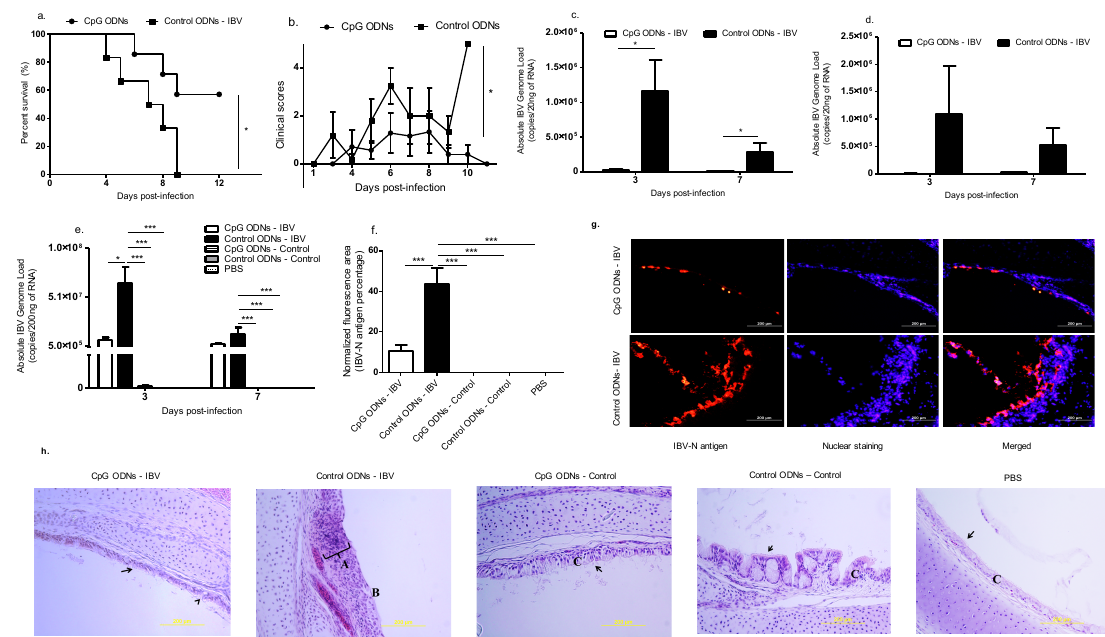
Figure 1. In ovo delivery of cytosine-guanosine (CpG) oligodeoxynucleotides (ODNs) is protective against infectious bronchitis virus (IBV) infection encountered post-hatch. Specific pathogen free (SPF) embryo day (ED) 18 eggs were delivered in ovo with class B CpG ODNs ( n = 7) or control ODNs ( n = 6), and on day 1 post-hatch, the chickens were infected with IBV M41 strain at a dose rate of 2.75 × 10 4 embryo infectious dose (EID 50 ) per bird, and were monitored until 11 days post infection (dpi). ( a ) Survival percentage and ( b ) clinical scores. ( c – h ): SPF ED 18 eggs were delivered in ovo with class B CpG ODNs ( n = 21), control ODNs ( n = 29), and phosphate buffered saline (PBS) ( n = 11). The eggs were incubated until hatching, and on day 1 post-hatch, a subset of in ovo CpG ODN-treated birds was challenged with IBV M41 strain at a dose rate of 2.75 × 10 4 EID 50 per bird ( n = 12), and the rest were kept as in ovo CpG pre-treated uninfected controls ( n = 9). Similarly, a subset of birds in the in ovo control ODN-treated birds was infected with IBV ( n = 18), and the remaining birds were kept as in ovo control ODN-treated uninfected controls ( n = 11). The in ovo PBS treated birds were kept as uninfected controls ( n = 11). A subset of birds from each group was sacrificed at 3 dpi ( n = 5-9 per group), and the remaining birds were sacrificed at 7 dpi ( n = 3–9) in order to obtain lung tissue. ( c ) IBV genome loads in oro-pharyngeal swabs at 3 and 7 dpi, ( d ) IBV genome loads in cloacal swabs at 3 and 7 dpi, and ( e ) IBV genome loads in 3 and 7 dpi lung. ( f – g ) The quantitative data and representative figures from the immunofluorescent assay of the trachea for IBV N antigen is presented. Scale Bar = 200 µ m ( h ) Representative images of histological observations of trachea are given. Control ODNs – IBV: Severe epithelial metaplasia with severe cellular infiltration, germinal center formation is seen (A), superficial epithelial layer has become squamous with complete loss of cilia (B) and mucus glands not detected. CpG ODNs-IBV: pseudostratified simple columnar epithelium and intact ciliated epithelia (arrow) is evident where some have become rounded, and a few mucus secreting glands have been distorted and elongated (arrow head). CpG ODNs-control, Control ODNs-control, and PBS-control: No lesions, normal pseudostratified ciliated columnar epithelium (C) with mucus secreting glands. Log-rank test was used to identify the differences in the survival rate, and the Kruskal–Wallis test followed by the Mann–Whitney U test were used to identify the differences in the clinical scores at selected time points. The student’s t test was performed to identify group differences in the oropharyngeal and cloacal genome loads, and one-way analysis of variance (ANOVA) followed by the Students–Newman–Keuls post hoc test was used to identify the differences in the lung IBV genome loads and IBV N antigen amount in the trachea. The differences were considered significant at * = significant at p ≤ 0.05, ** = significant at p ≤ 0.01 *** = significant at p ≤ 0.001. c–h: the animal numbers and results represent the pooled data of the two independent